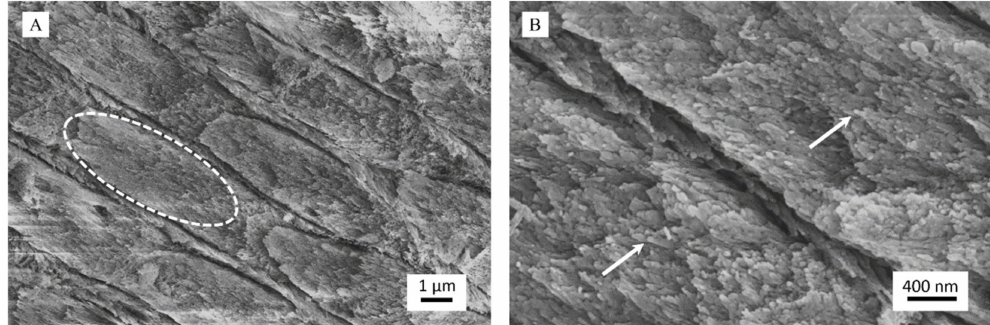
Figure 4. Representative field-emission scanning electron microscope (FEG-SEM) micrographs of demineralized dental enamel after control treatment (water only) at magnification levels of ( A ) 25,000 × and ( B ) 50,000 × : In ( A ), an enamel prism is enclosed in a white ellipse. In ( B ), single native hydroxyapatite (HA) nanocrystals are marked by white